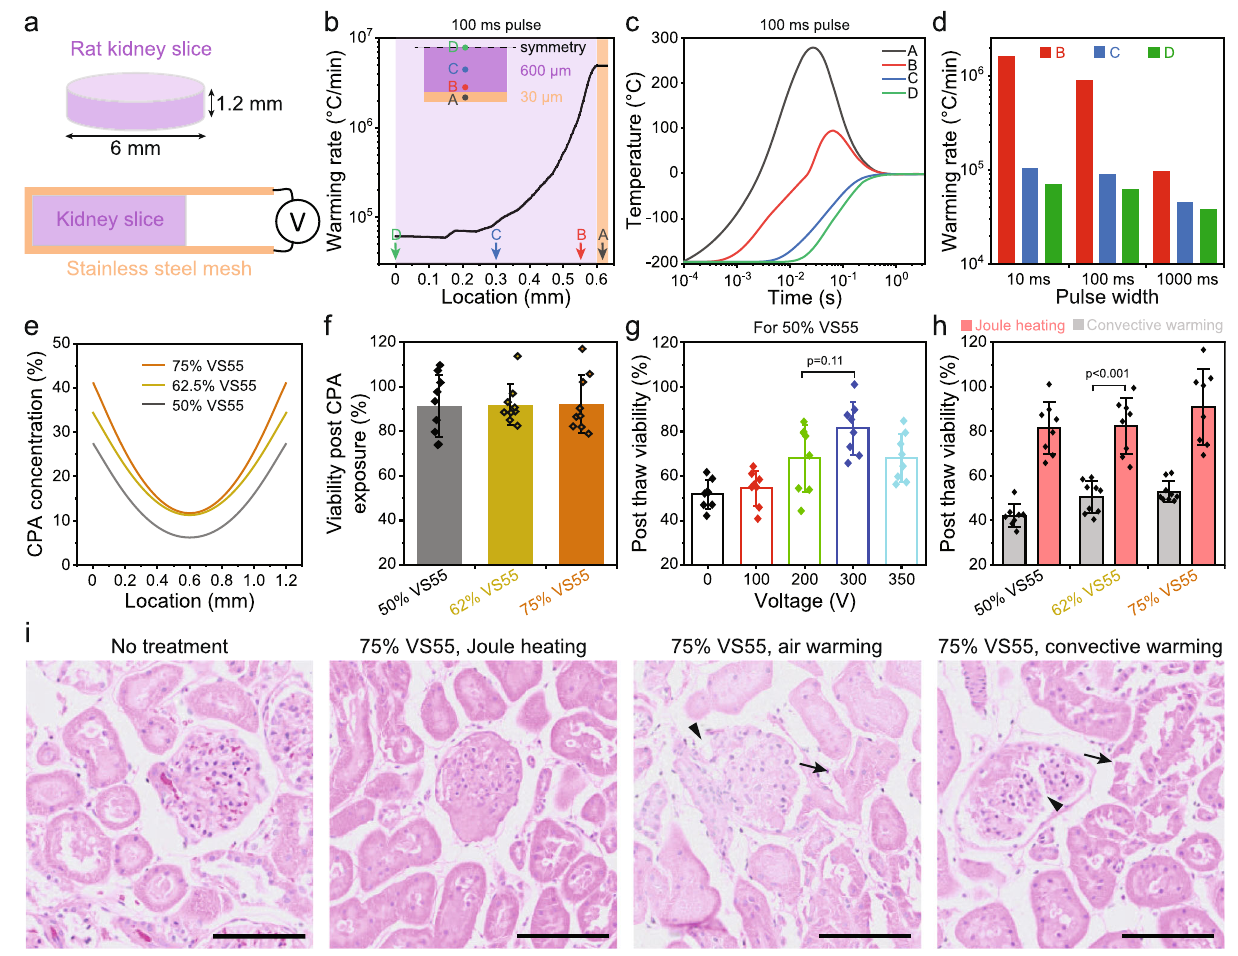
Fig. 5 | Kidney slice cryopreservation using joule heating. a Rat kidney slices of 1.2mm thickness and 6mm in diameter were used. After cryoprotective agent (CPA) loading, the kidney slice was sandwiched using the stainless steel (SS) mesh prior to plunge-cooling in liquid nitrogen, then rewarmed by connecting the SS meshtoavoltagesource. b Warmingratedistributionwithinthekidneyslice.Point A represents the SS mesh; B, C, and D represent the kidney slice. The detailed locationsof pointsA,B, C, and D weremarked in the plot. c Temperaturepro fi le at different locations (point A to D) for 100ms joule heating. d Warming rates at different locations within the kidney slice using 10ms, 100ms, and 1000ms joule heating. e CPAconcentrationdistributionwithinthe kidneysliceafterloading with differentCPAconcentrations. f Viabilityofkidneyslicesafterexposureto different